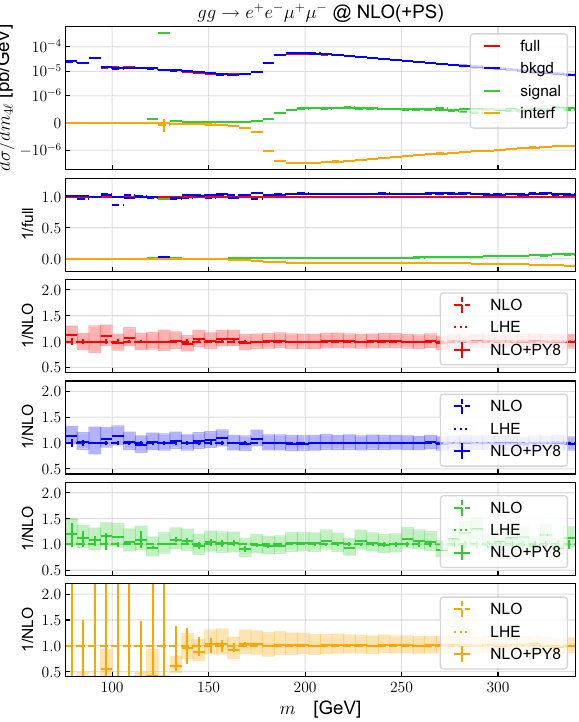
Fig. 3 Differentialdistributionininvariantmass m 4 (cid:3) ofthefour-lepton system in gg → e + e − μ + μ − at NLO matched to PYTHIA 8 . The upper panel shows nominal predictions at fixed-order NLO (dashed) for the background (blue), the signal (green) and the interference (orange) separately and their sum (red) together with NLO+PS pre- dictions (solid). For the nominal prediction we use a symlog scale with a linear threshold=10 − 6 . The first ratio plot shows the relative yield of thedifferentcontributionswithrespecttothefull,bothatthefixed-order NLO level and also after parton shower. The lower four ratio plots show the LHE level (dotted) and fully showered corrections with respect to fixed-order NLO for the sum of all contributions (second ratio plot), the background only (third ratio plot), the signal only (fourth ratio plot), and for the interference only (fifth ratio plot). The band associated to NLO+PS predictions indicates the 7-point scale variation